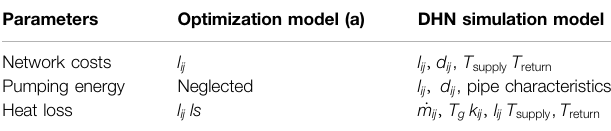
TABLE 1 | Summary of key parameters used in the optimization model 1) and the DHN simulation model.